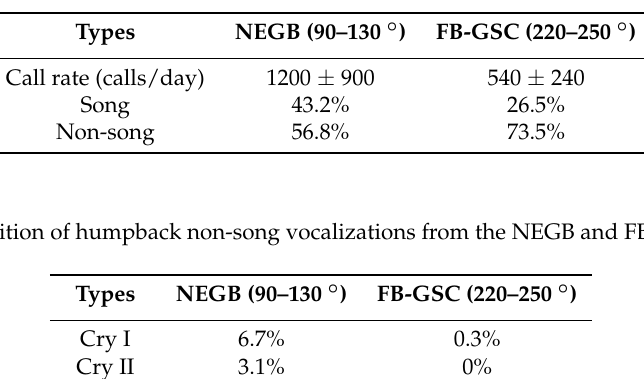
Table 1. Recorded diel humpback vocalization rates originating from the northeastern Georges Bank (NEGB) direction and Franklin Basin to Great South Channel (FB-GSC) direction.